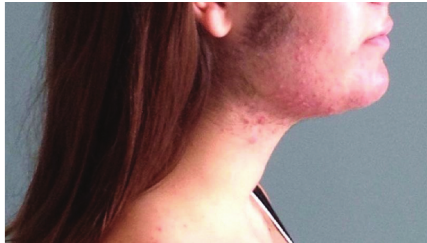
Figure 4: Four months after delivery.